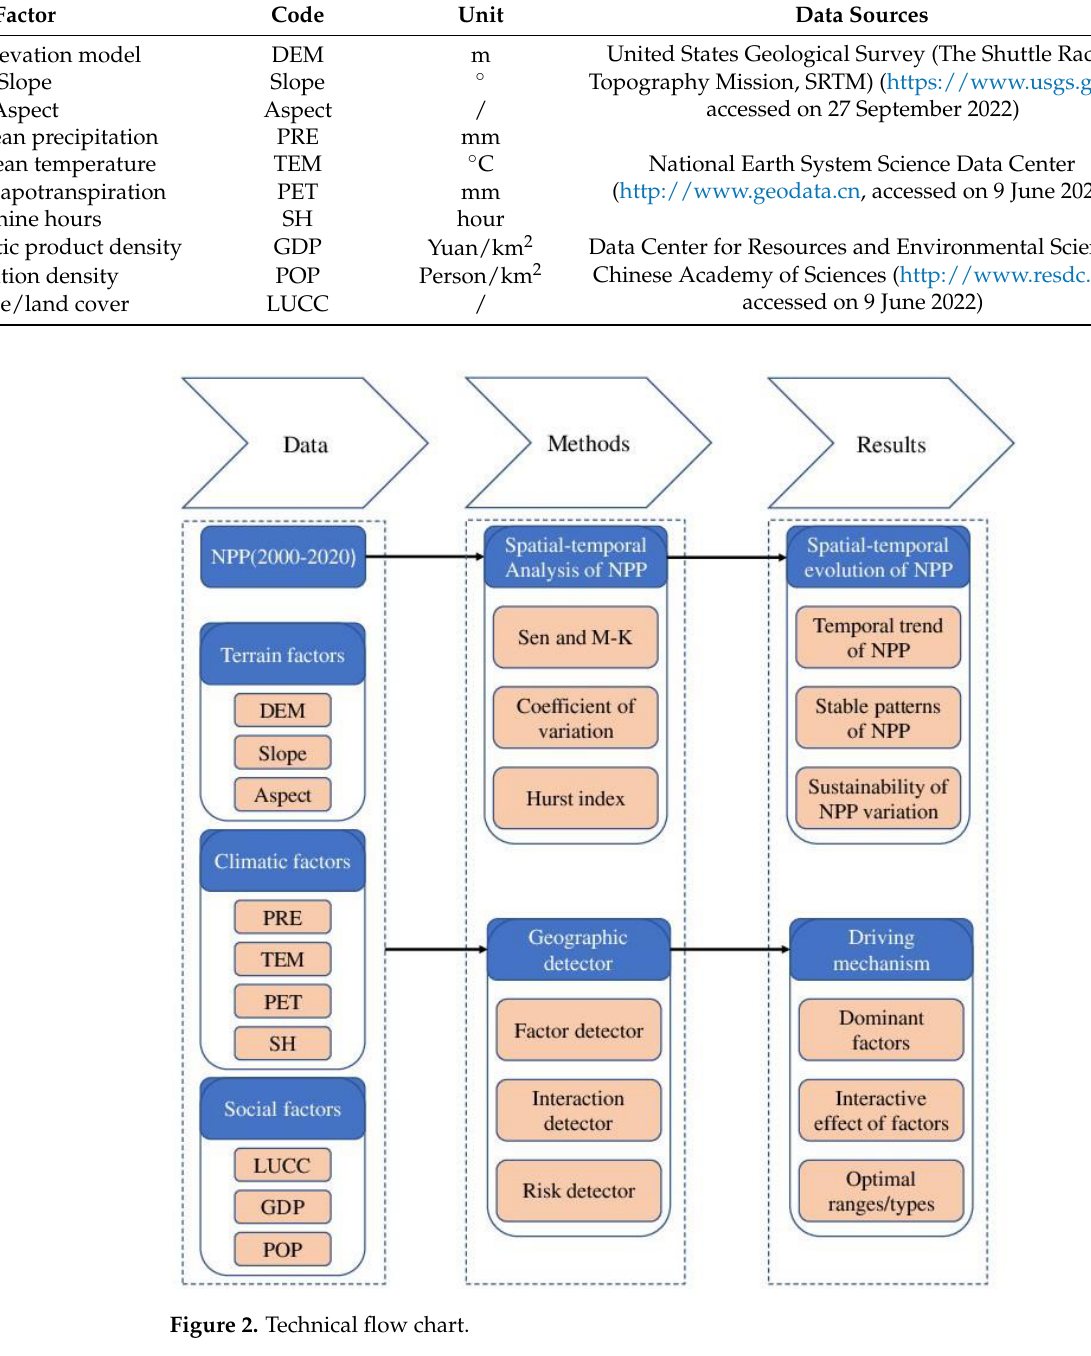
Figure 2. Technical flow chart.